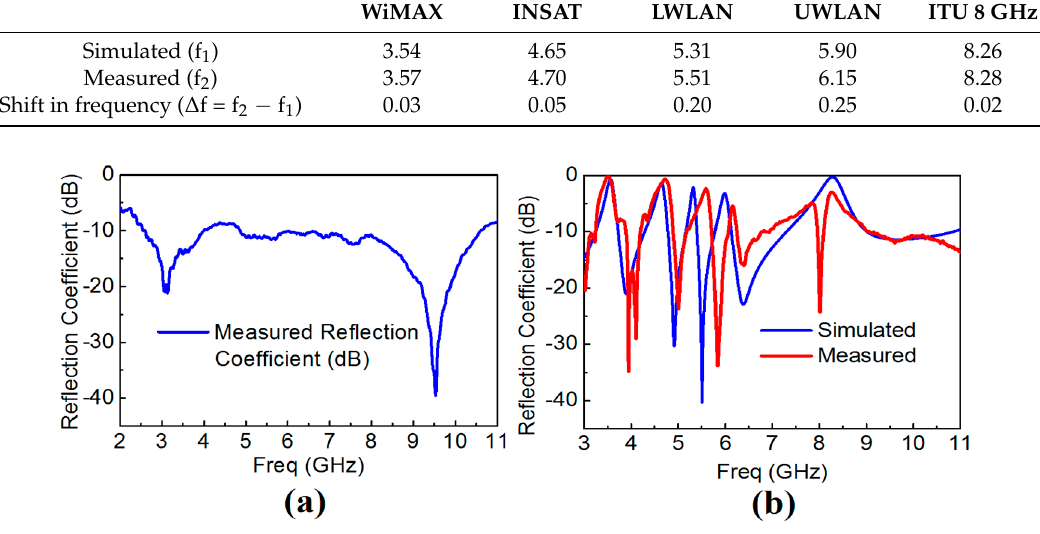
Figure 8. The measured frequency response of the reference and proposed quintuple band-notched UWB antenna ( a ) Measured reflection coefficient of the reference antenna; ( b ) Measured vs. simulated reflection coefficient of the proposed quintuple band-notched antenna. Table 3. Discrepancies between the simulated and measured results when simulated with W s = 0.348 mm.